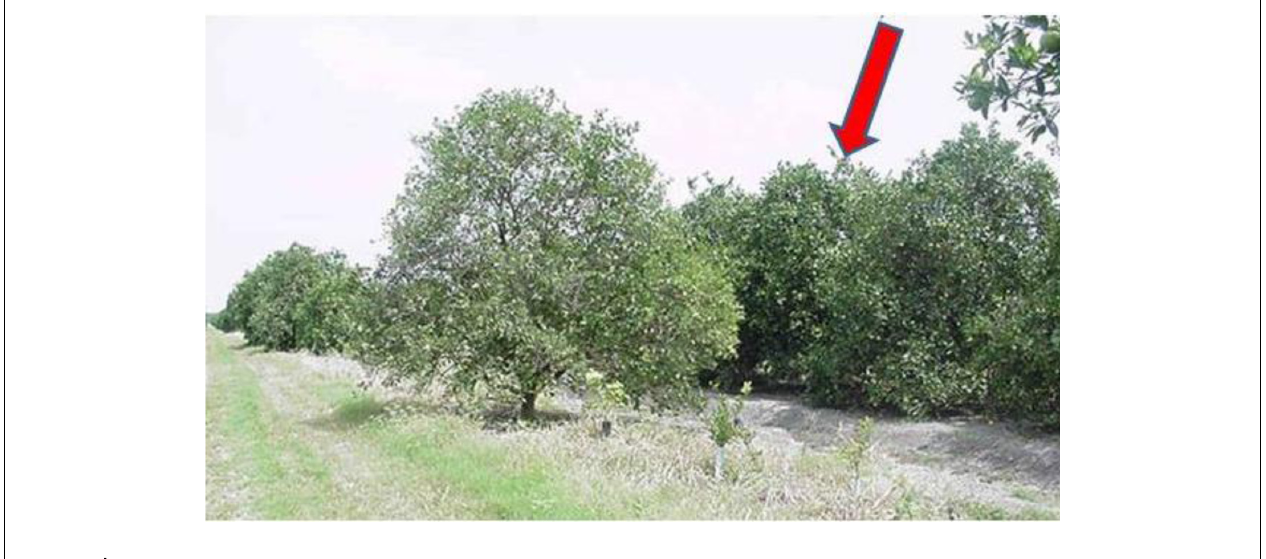
FIGURE 2 |An example of a surviving tree (red arrow) in a grove of Valencia sweet orange on sour orange rootstock. Missing trees result in empty tree spaces or recently planted new trees.The trees surrounding the